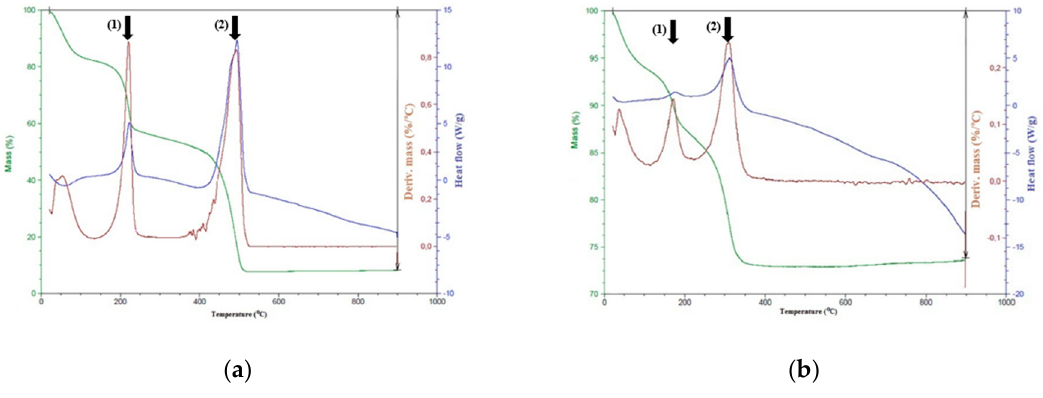
Figure 5. TGA curves for NGO ( a ) and γ -Fe 2 O 3 @NGO ( b ).